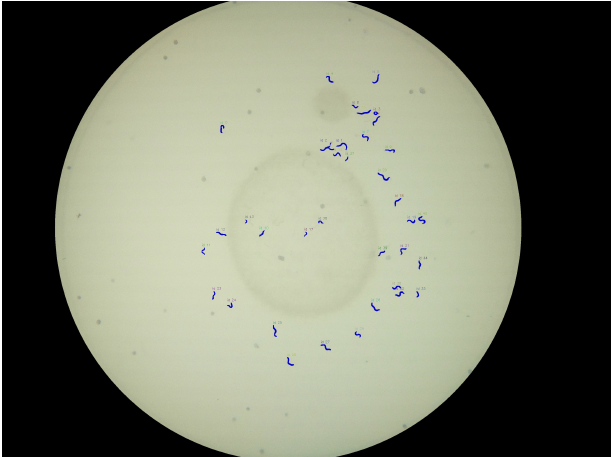
Figure 8. Resulting classified image-version of the example image: blue masks result from model- classifier; red and yellow: bounding boxes, nematode-IDs.